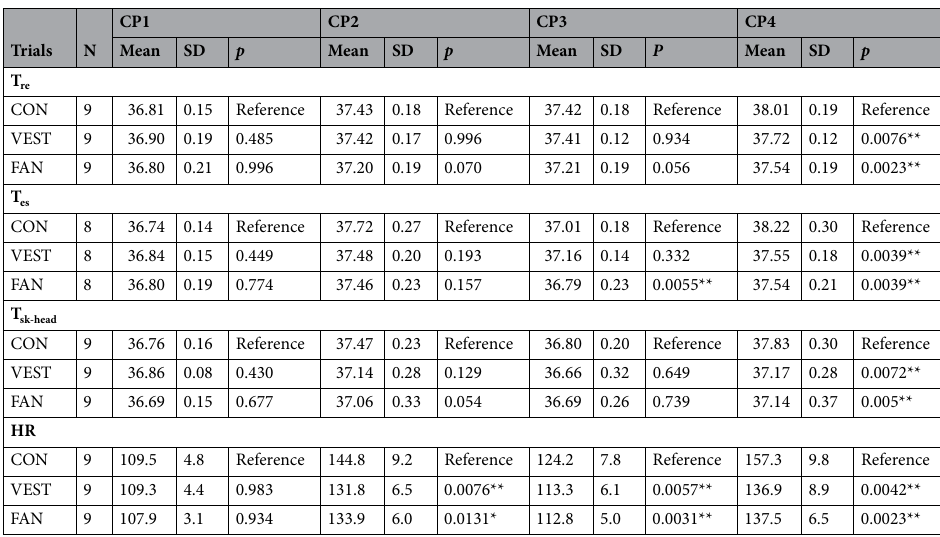
Table 1. Rectal temperature (T re ), esophageal temperature (T es ), and skin temperature of the frontal head (T sk-head ) and heart rate (HR) at each checkpoint. CON participants did not wear any cooling garment, VEST participants wore a circulating-water cooling vest, FAN participants wore a fan-attached jacket. CP1: 23 min 00 s to 27 min 50 s, CP2: 48:00–52:50, CP3: 77:00–81:50, CP4: 102:00–106:50. The p values for T re , T es , and HR were determined by the Steel–Dwass test; the p value for T sk-head was determined by the Tukey–Kramer test. * p < 0.05. ** p < 0.01.